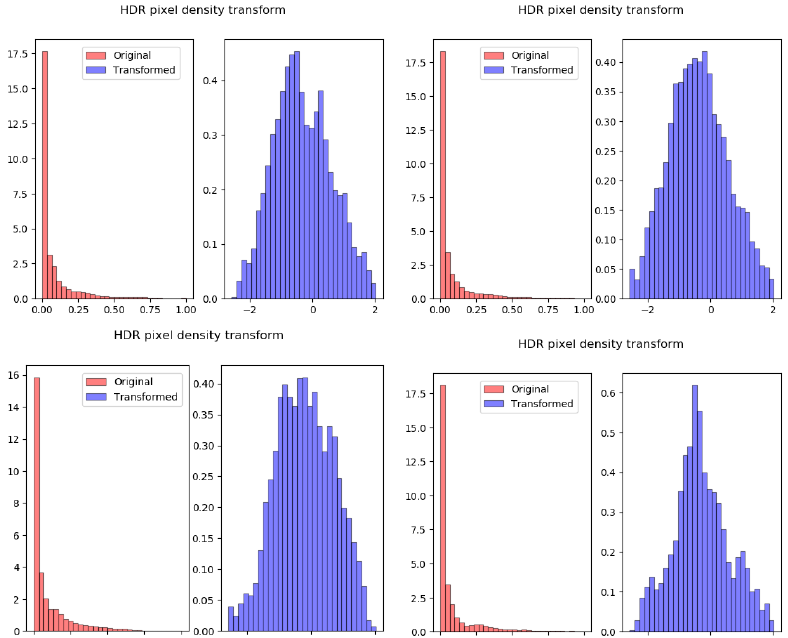
Figure 3. Histograms for HDR pixel distributions before and after the density transform. The four subfigures represent four different samples of 256 × 256 HDR image mini-batches of size 32. There is some variation observed in the resulting Gaussian distributions, due to the variation in HDR content and the approximation that HDR pixels follow an exponential